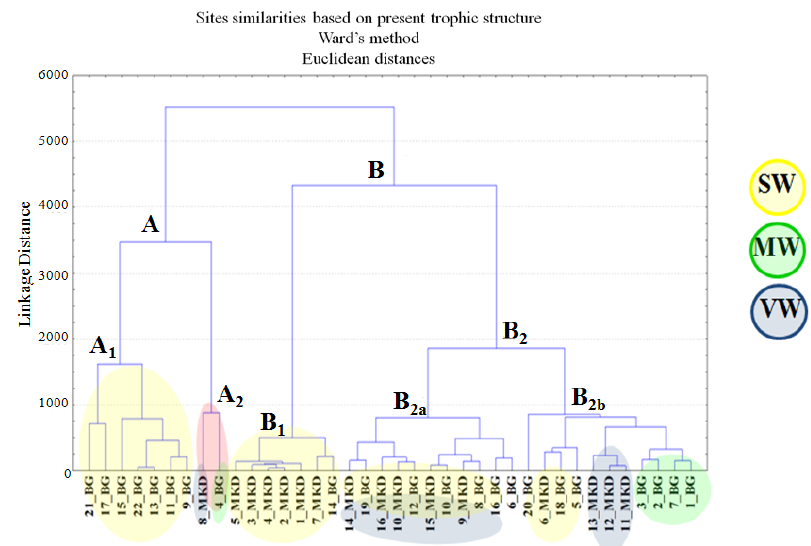
Figure 6. A cluster dendrogram of the similarity between the sampling sites based on the absolute abundance of the FFG (For abbreviations and site codes, see Materials and Methods). The red circle (subgroup A 2 ) represents the most polluted sites.